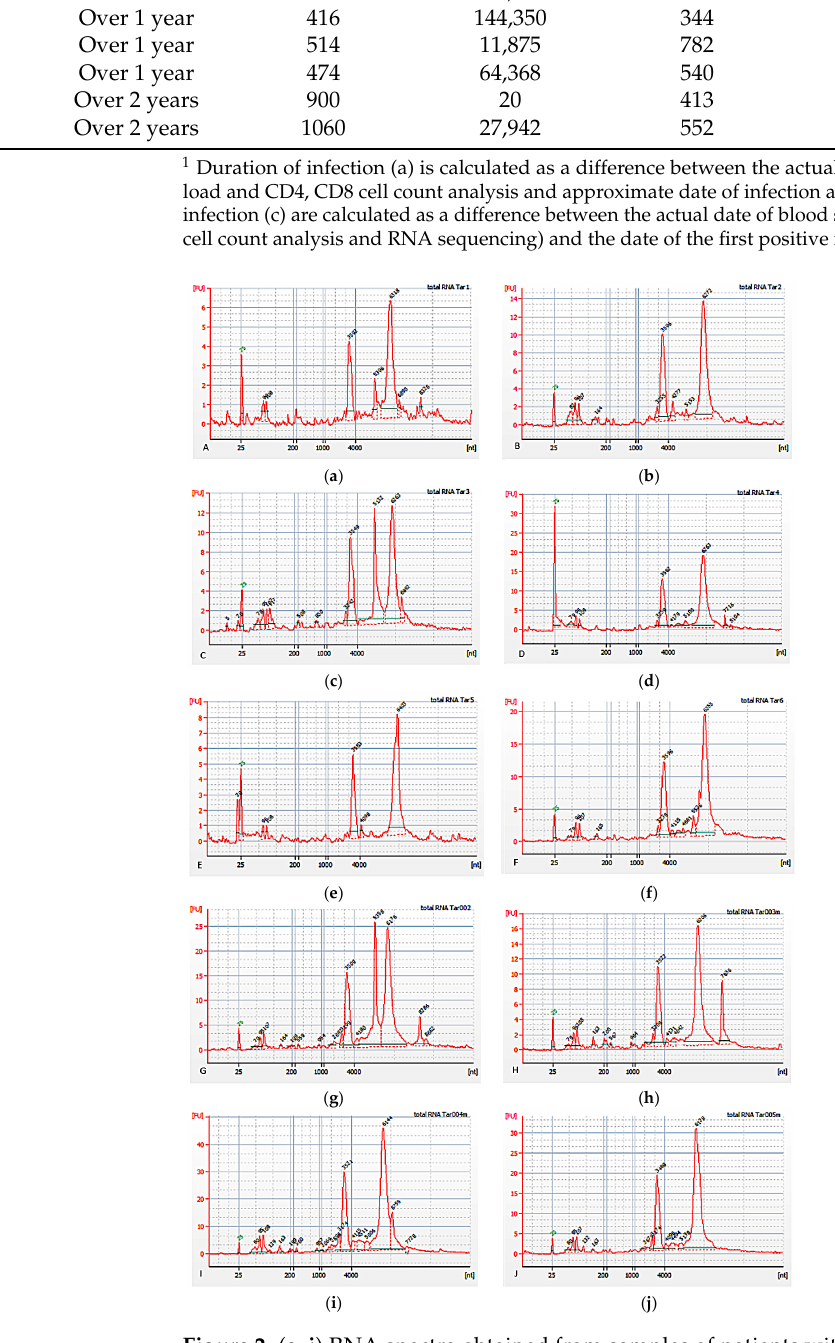
Figure 2. ( a – j ) RNA spectra obtained from samples of patients with